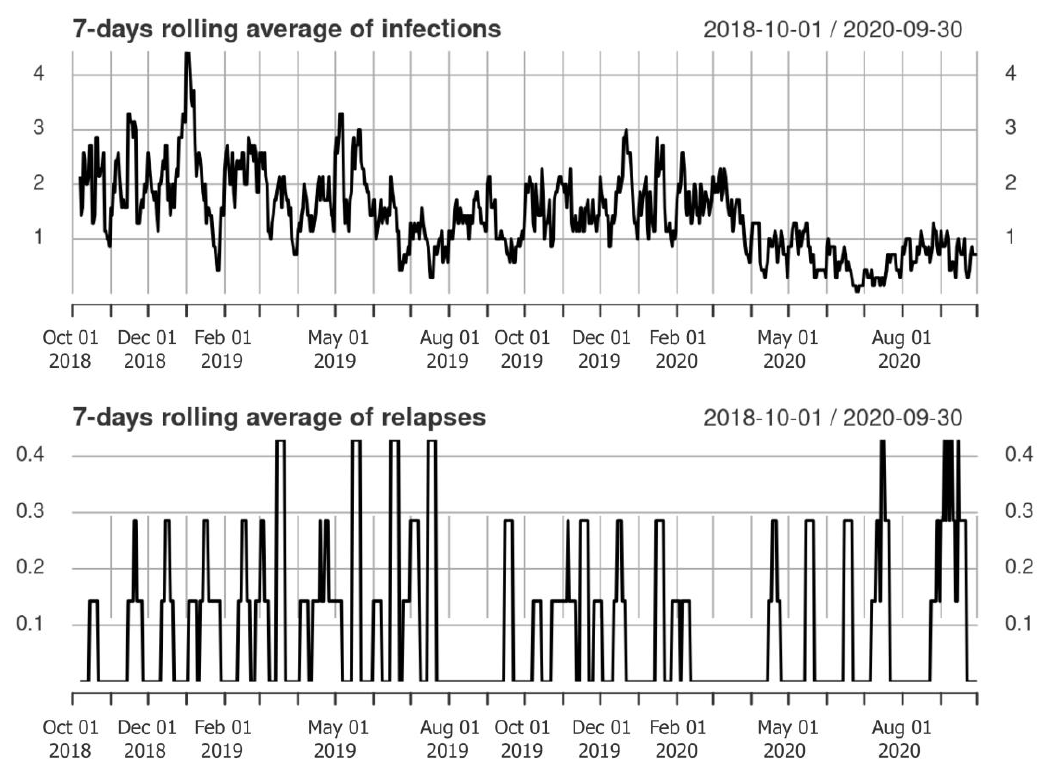
Figure 1. Frequencies of infections and relapses from October 2018 to September 2020.